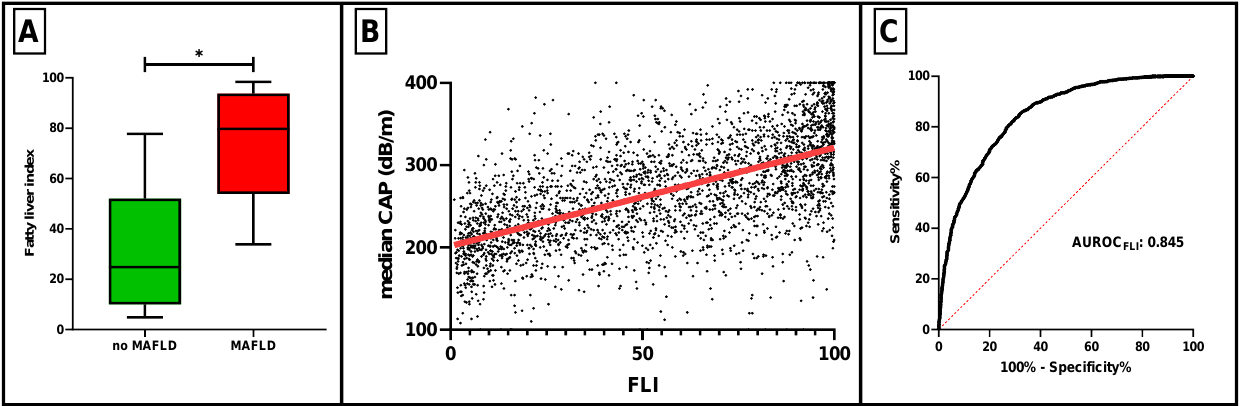
Figure 2. Fatty liver index (FLI) in metabolic dysfunction-associated fatty liver disease (MAFLD). ( A ) Box plots demonstrating the differences in FLI according to the presence of MAFLD. ( B ) Spearman correlation analysis of FLI with elastography-derived median controlled attenuation parameter (CAP). ( C ) Receiver operating characteristics (ROC) curve for the assessment of FLI’s diagnostic accuracy concerning MAFLD. AUROC: area under receiver operating characteristics curve. * indicates statistically significant difference ( p < 0.05).